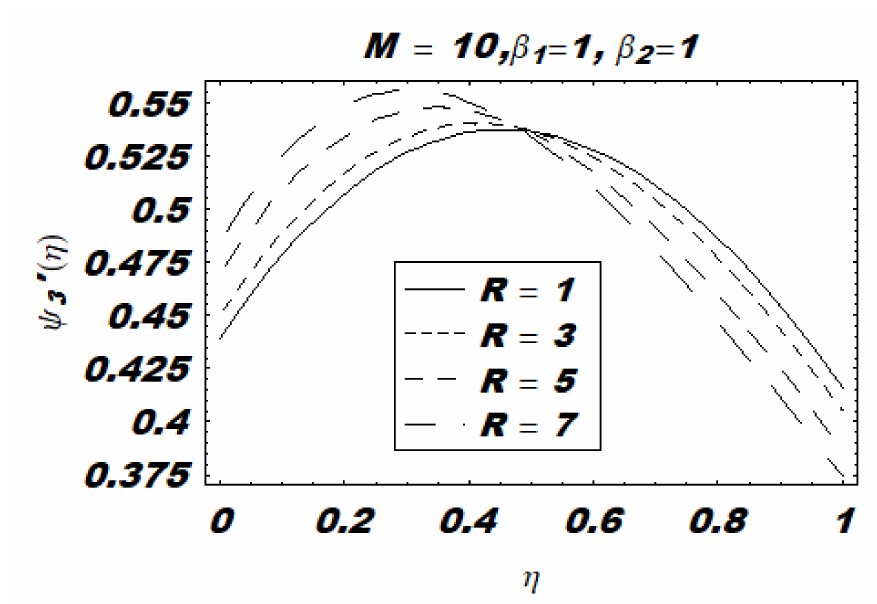
Figure 27. Similarity function ψ /